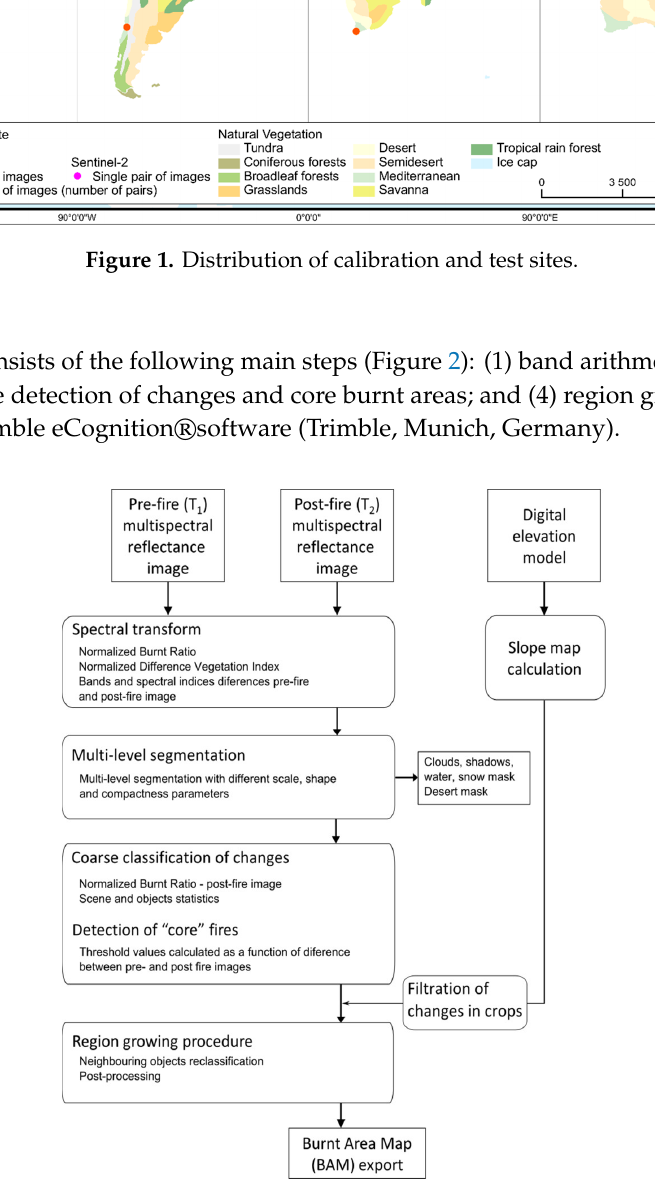
Figure 2. Burnt area mapping workflow.